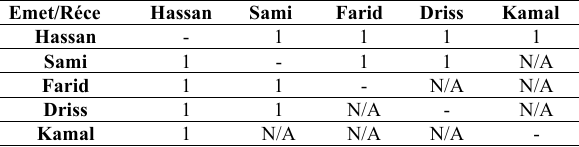
TABLE VIII R ESULTS OF SHARING A « P HOTO » PUBLICATION A FTER USING